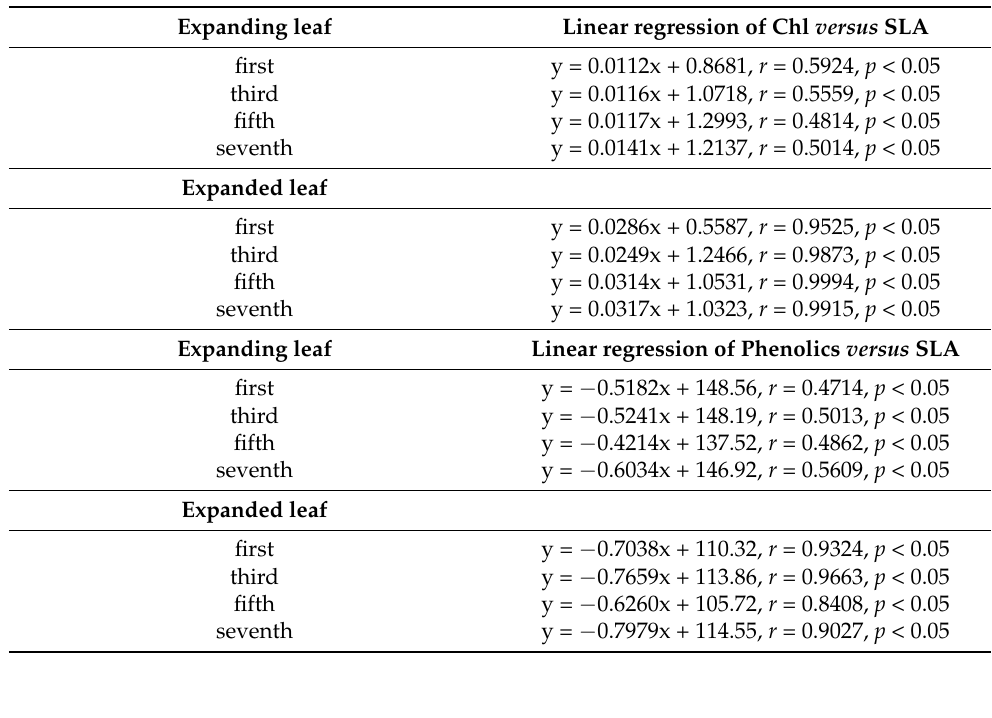
Table 4. Linear regressions of total chlorophyll and phenolic content versus specific leaf area (SLA) of expanding and fully expanded leaves of C. siliqua .